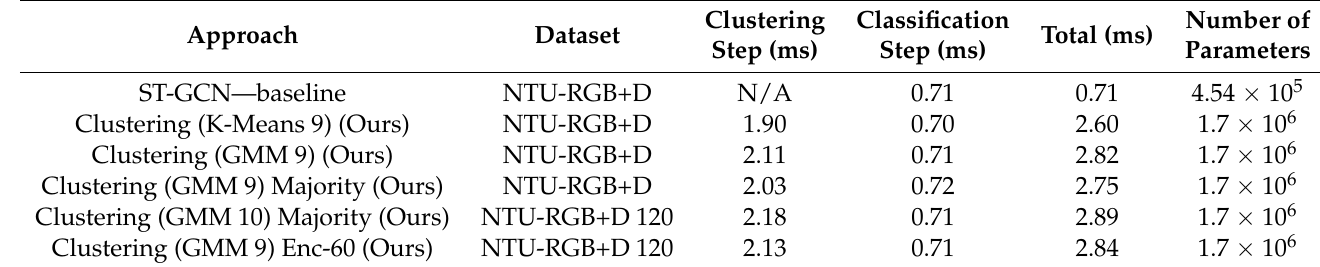
Table 10. Performance results of the proposed